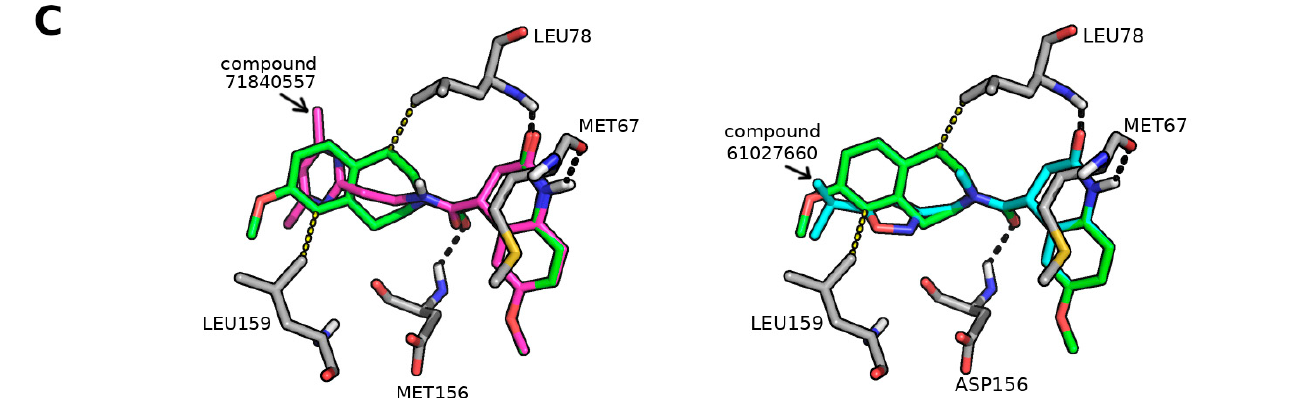
Figure 20. Protein–ligand interactions for the pairs in the SAR core #1 ( A ) and core #2 ( B ) involving the most active compound (24940823) in the RIPK1 inhibition assay. Hyd: hydrophobic contact, H-don: H-donor, H-acc: H-acceptor. ( C ) Docked poses of the compounds (71840557 in magenta and 61027660 in cyan) sharing the first core with 24940823 (in green). Only key differing contacts are proven to prevent the figure from becoming overly crowded with residues.